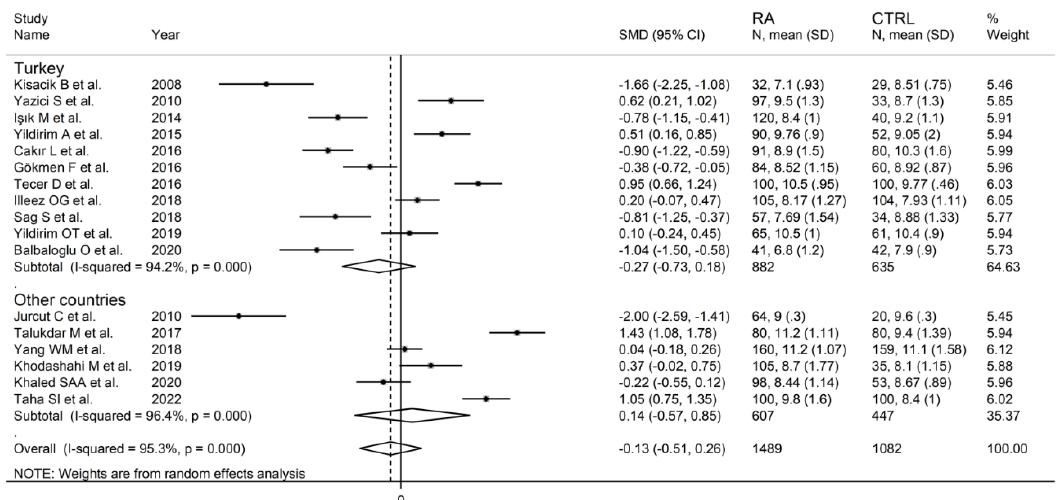
Figure 5. Forest plot of studies examining the mean platelet volume in patients with rheumatoid arthritis and healthy controls according to study design.